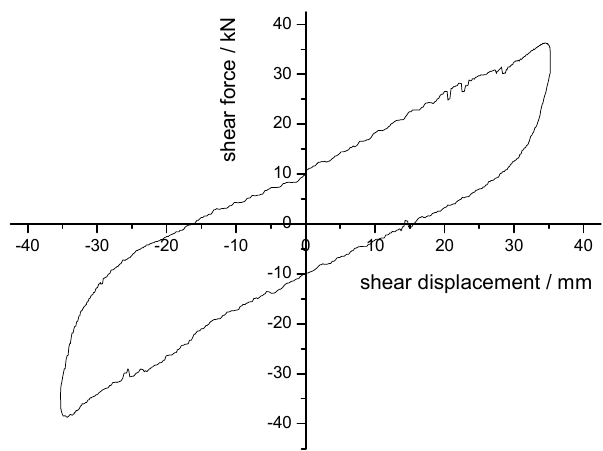
Figure 6. Constitutive relationship of the high damping rubber (HDR) bearing.